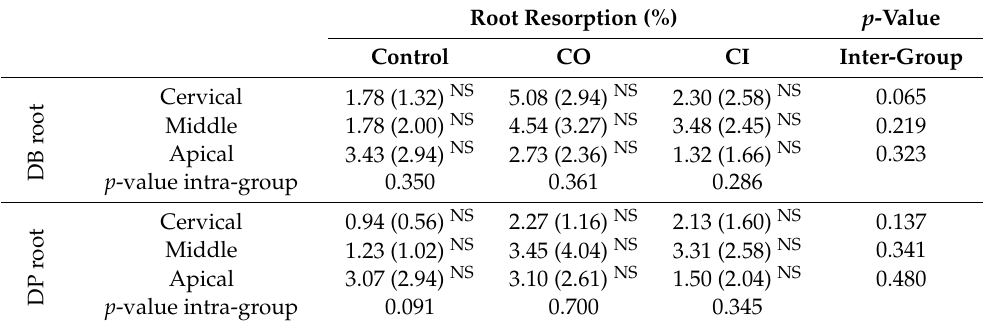
Table 1. Comparison of percentages of root resorption between the control, CO, and CI groups. Root Resorption (%) p -Value Control CO CI